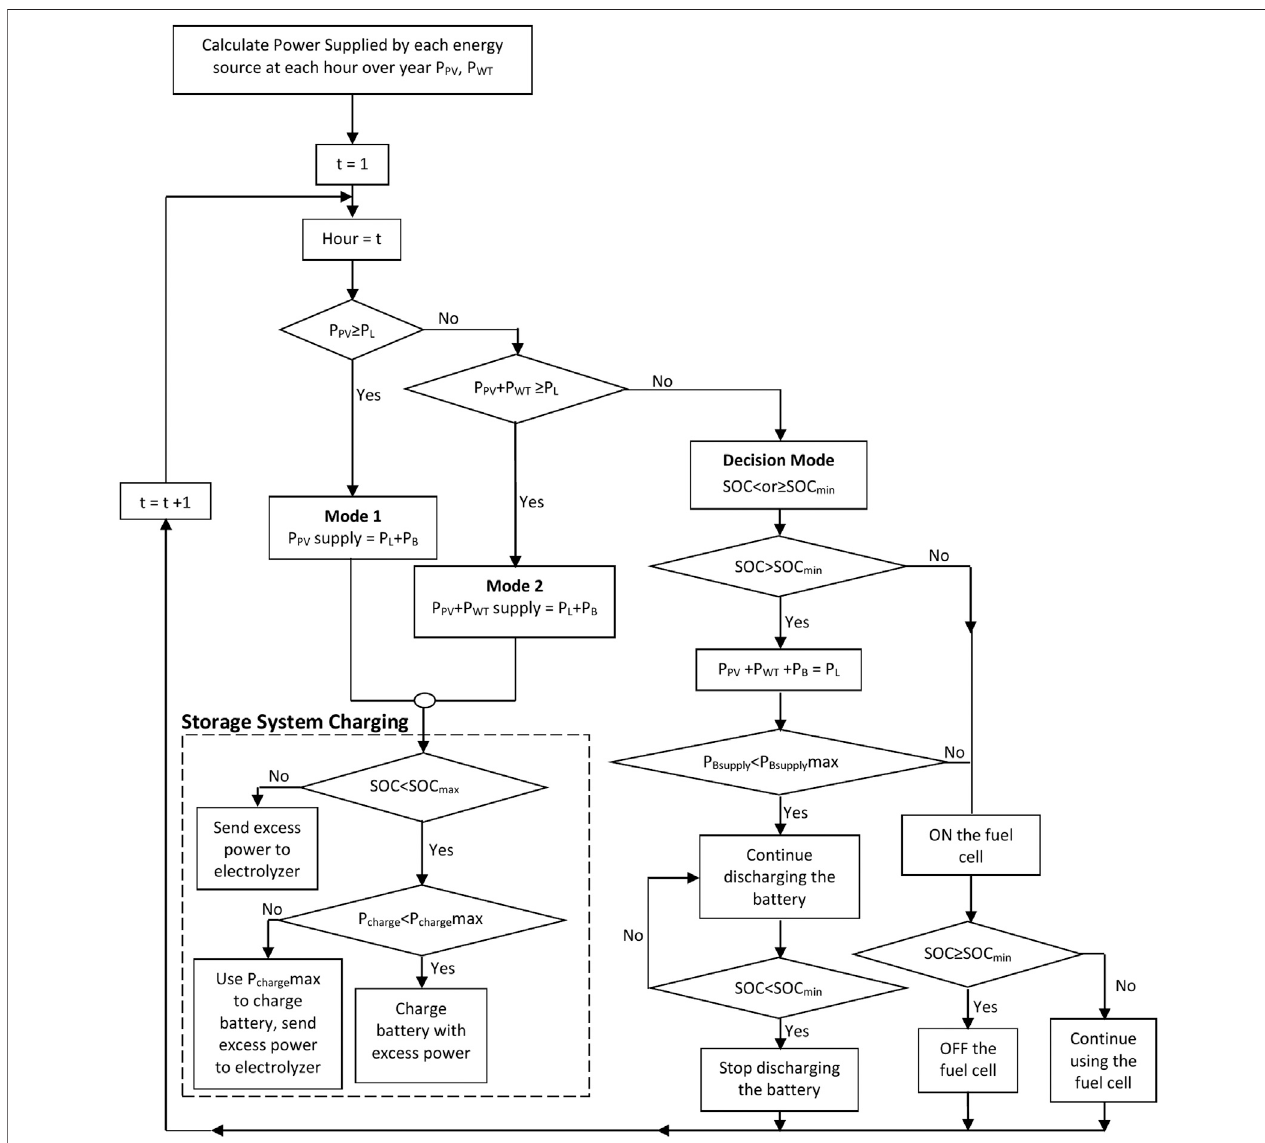
FIGURE 4 | Intelligent Power Management System and its modes of control for the system